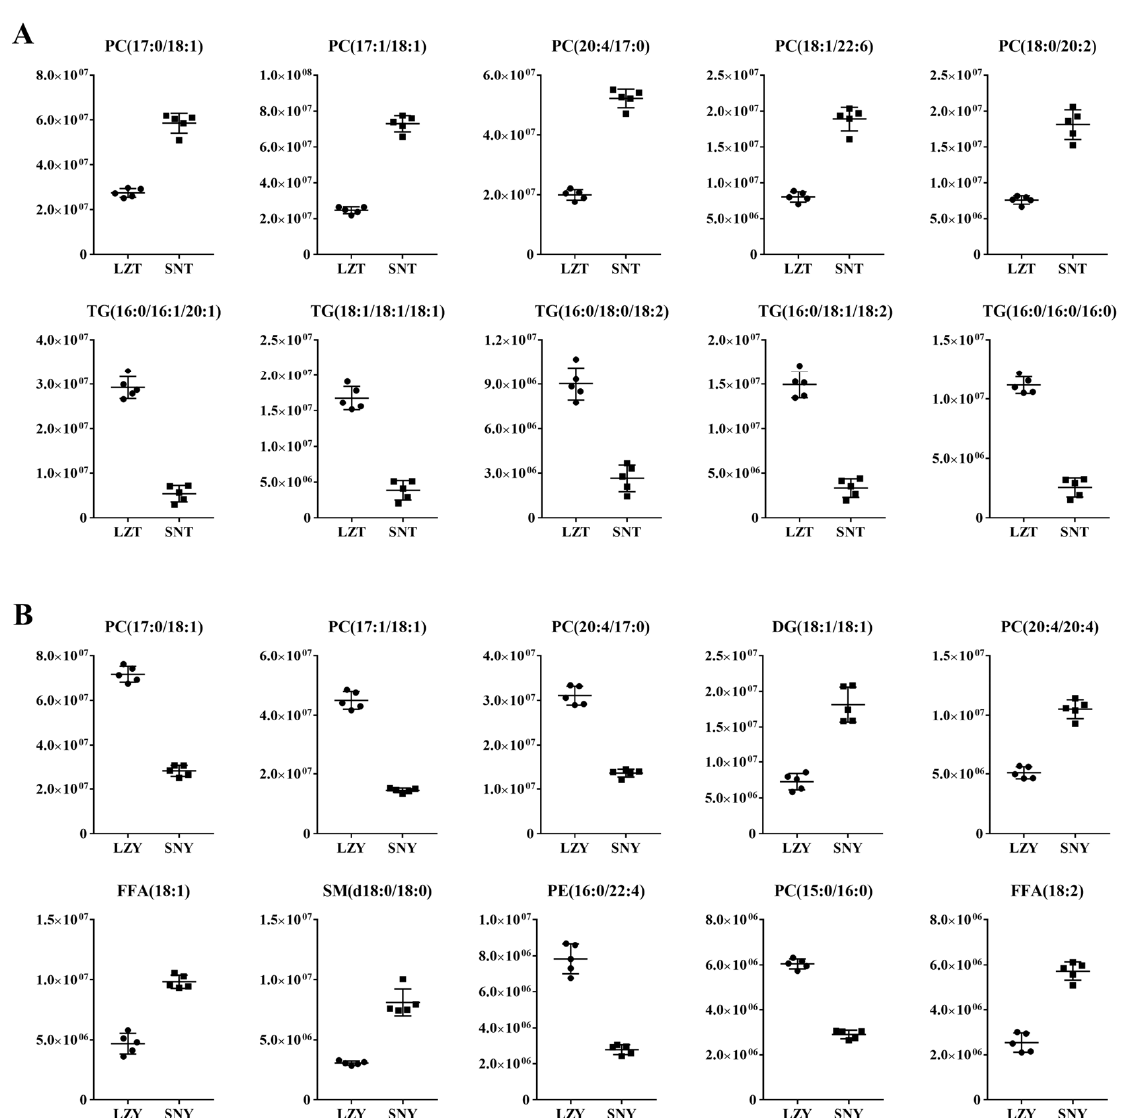
Figure 5. Representative DALs in the livers of Tibetan and Yorkshire pigs raised at different altitudes.